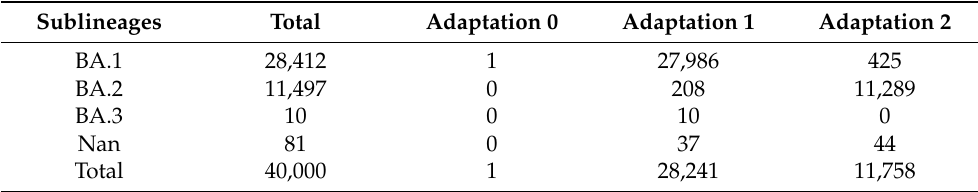
Figure 4. Performance of sequential AA-based CNN to predict the human adaptation of SARS-CoV-2 variants. ( A – C ) The performance of the sequential AA-based CNN model was assessed by the pair plot of PCA1 and PCA2 of the full connection layers from the CNN model post-training epochs of 10, 20, and 30 (( A – C ) for training epochs of 10, 20, and 30, respectively); ( D ) The training loss for the CNN model was curved for 30 training epochs; ( E , F ) Confusion matrix ( E ), receiver operating characteristic curve (ROC) ( F ), and training (( D – F ) for training epochs of 30). Statistical significance in the PCA1 or PCA2 values of the full connection layers between two neighboring adaptation groups is indicated, respectively, according to an unpaired, nonparametric Mann–Whitney test. Table 1. Adaptation prediction of sampled Omicron variants of various sublineages, with the trained CNN